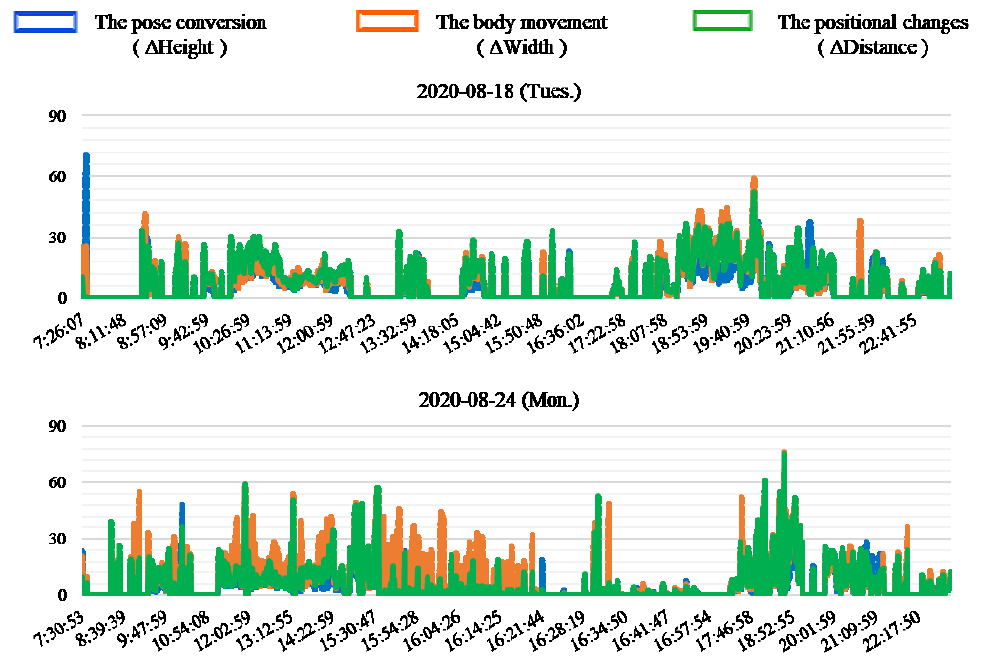
Figure 10. Example of the results of the typical two days in this